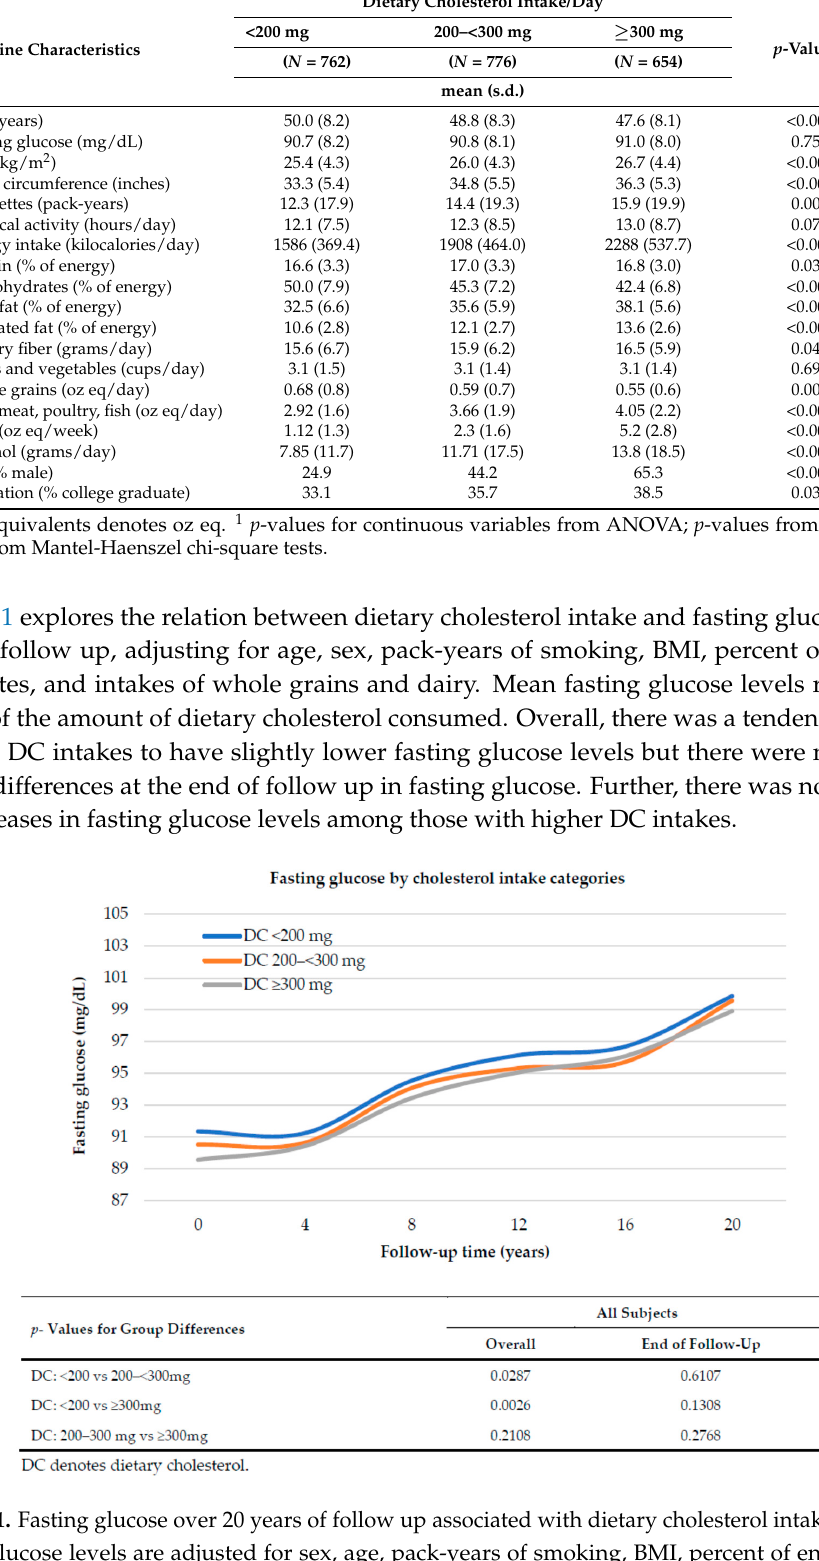
Table 1. Baseline characteristics of Framingham Offspring Study subjects according to dietary cholesterol intake.